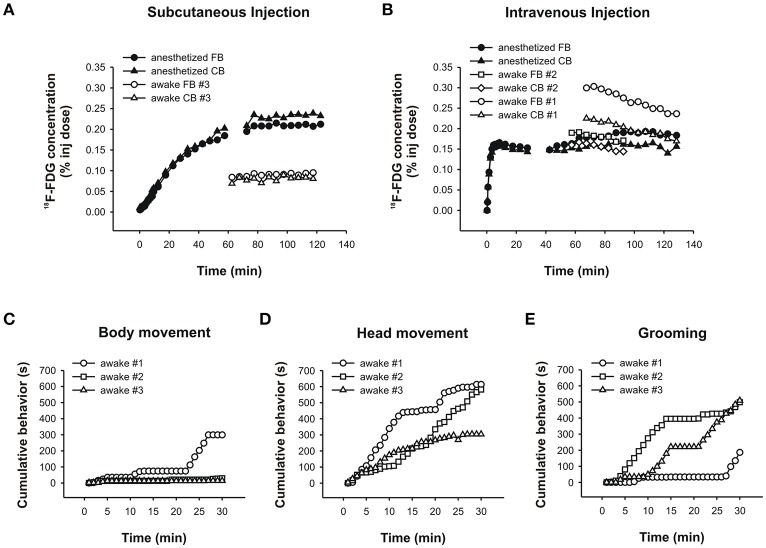
PET data and behavioral analyses for the chicken. Time-activity curves for the chicken following a (A) subcutaneous injection of 18F-FDG showing an anesthetized (black symbols) and an awake (white symbols) uptake study. Circles and triangles show uptake in the forebrain and cerebellum, respectively. (B) Intravenous injection of 18F-FDG showing an anesthetized (black symbols) and two awake (white symbols) uptake experiments. Circles and squares show uptake in the forebrain, and triangles and diamonds show uptake in the cerebellum. The time-activity curves for the anesthetized animal is shown in two parts due to subjectmotionmidway through the scan. Durations (s) of (C) bodymovement, (D) headmovement and (E) grooming were summed for each 1min time bin and cumulated. The rank order of chickens spending time engaging in each behavior changed when the initial 5–10min were considered versus the entire 30min of 18F-FDG uptake.